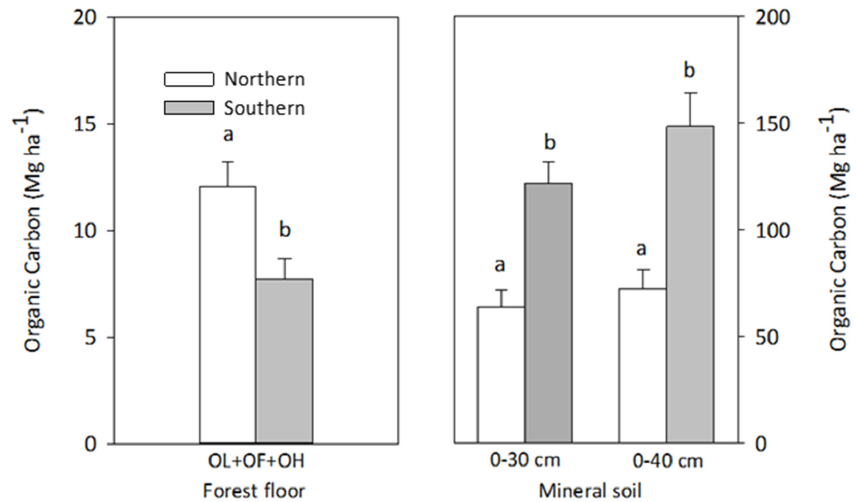
Figure 4. C stocks in forest floor and mineral soil in a northern and a southern beech forest. C stocks in the mineral soil 0–30 cm depth are reported for comparison with INFI data. Values are means ± standard error; n = 36 (6 sampling plots, 2 sampling seasons, 3 replicate analyses). Different lower ‐ case letters indicate significant differences between sites ( t test; overall significance level = 0.05).